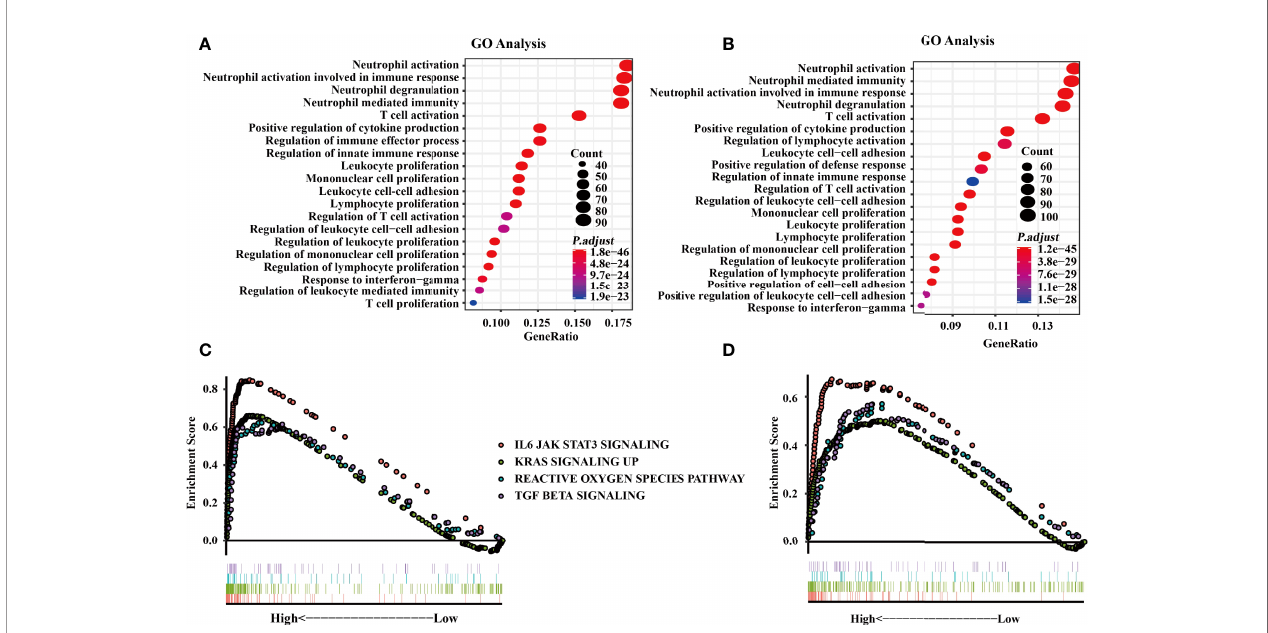
FIGURE 5 | Functional enrichment analysis with The Cancer Genome Atlas (TCGA) and the Chinese Glioma Genome Atlas (CGGA) databases. (A) Gene Ontology (GO) analysis from the TCGA database. (B) GO analysis from CGGA databases. (C) Gene Set Enrichment Analysis (GSEA) was conducted to investigate the biological functions of SIGLEC9 in gliomas from the TCGA database. (D) GSEA was conducted to investigate the biological functions of SIGLEC9 in gliomas from the CGGA database. The red lines represent SIGNALING as IL6 JAK STAT3. The green line represents KRAS signaling up. The turquoise line represents the reactive oxygen species pathway. The purple line represents TGF- b signaling.